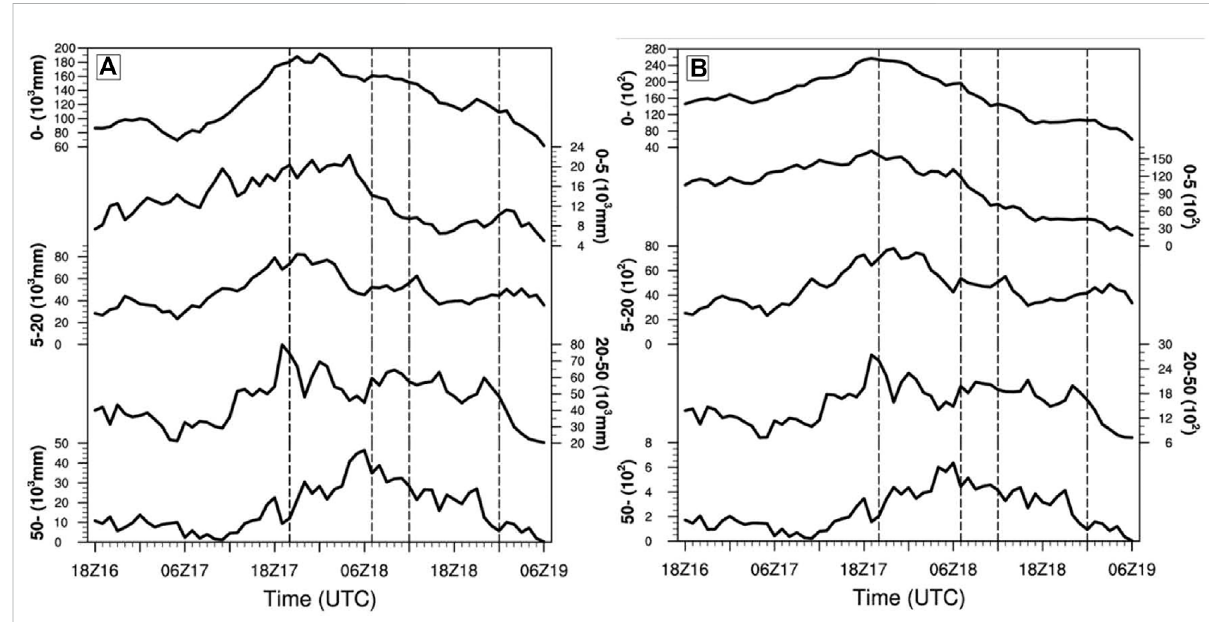
FIGURE 3 Time series of (A) total rainfall (unit: mm) and (B) numbers of grid points of different hourly rainfall intensities in the gale circle. The fi rst vertical dotted line represents the moment when the gale circle began to touch the land. The other three vertical dotted lines correspond to the moments when Rammasun landed in China three